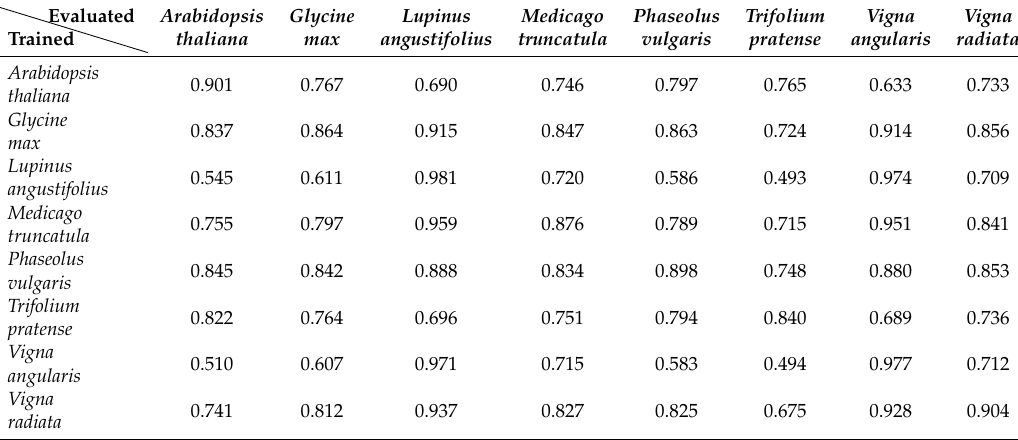
Table 2. ACC values of the intra- and inter-species promoter classification using the species-specific trained CNNs. Off-diagonal numbers are ACC values for inter-species classification, diagonal numbers are ACC values for intra-species classification. For instance, a CNN trained on Lupinus angustifolius and used for classification of Vigna angularis promoters has an accuracy of 0.974. Glycine Lupinus TrainedEvaluated Arabidopsis thaliana max